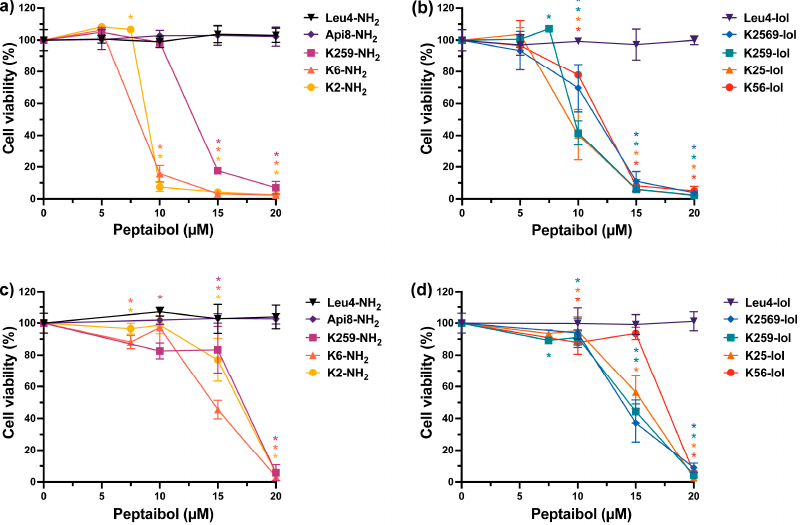
Figure 4. (Cytotoxicity of trichogin GA IV analogs toward triple negative breast cancer cells MDA-MB-231 ( a , b ) and normal breast cells MCF-10A ( c , d ). Cells were exposed to increasing concentrations of peptaibols for 24 h, and viability was measured with the MTS assay at the end of the incubation time. Data are expressed as mean percentage ± SD of at least three independent experiments, carried out in triplicate. *: p < 0.001, significantly different from controls ( t -test). Table 3. IC 50 (expressed in µM ) values measured in MDA-MB-231 and MCF-10A cells exposed to peptaibols for 24 h.